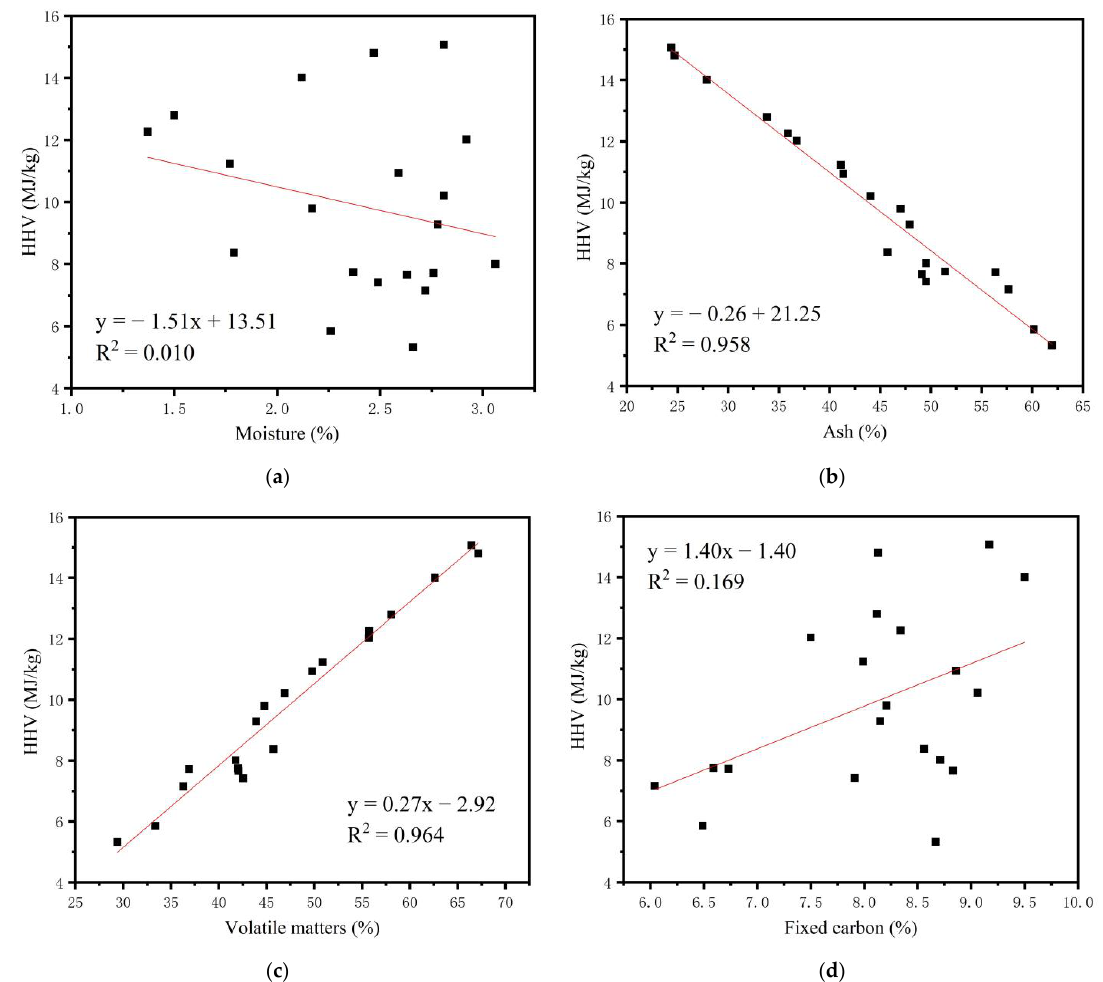
Figure 2. Correlation between HHV and proximate analysis data: ( a ) indicates the correlation between moisture and HHV; ( b ) indicates the correlation between ash and HHV; ( c ) indicates the correlation between VM and HHV; ( d ) indicates the correlation between FC and HHV.